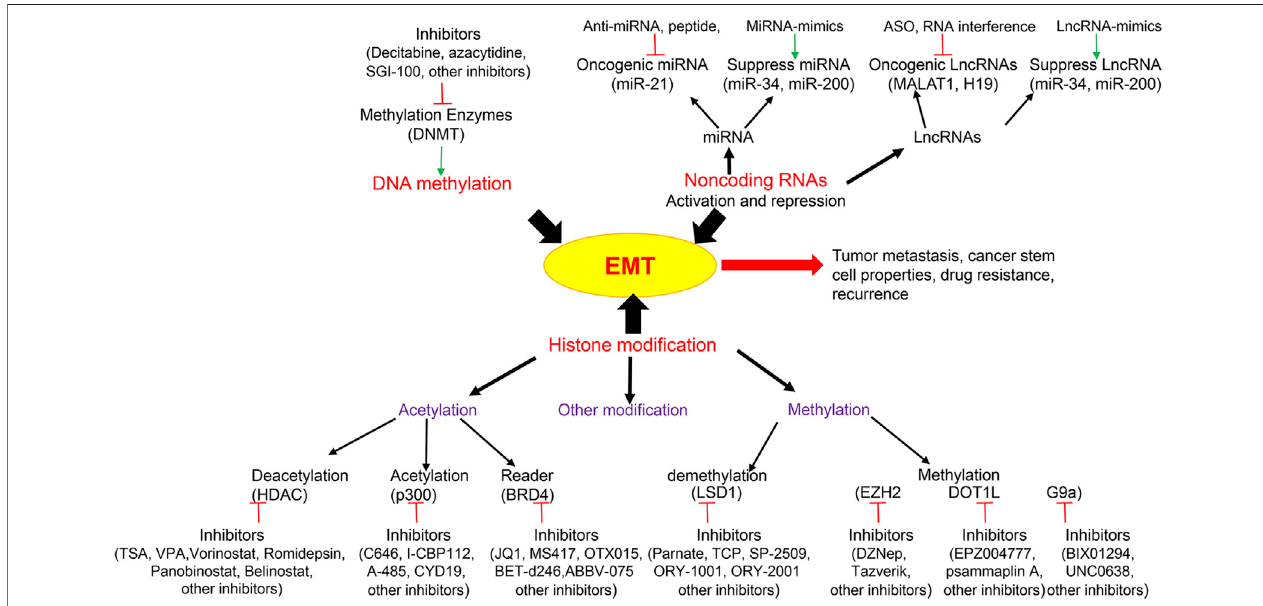
FIGURE 1 | Epigenetic modi fi cations and related key inhibitors involved in Epithelial-Mesenchymal Transition (EMT). Epigenetic regulations including DNA methylation, histone modi fi cation and non-coding RNAs are integral to EMT which contribute to tumor metastasis, cancer stem cell properties, drug resistance and recurrence. Epigenetic drugs are illustrated to inhibit EMT including histone deacetylase (HDAC) inhibitor, histone acetylase inhibitor, acetylation reader inhibitor, histone methyltransferase inhibitor, histone demethyltransferase inhibitor, DNA methyltransferase (DNMT) inhibitor, and non-coding RNA activation and repression. LncRNA, Long non-coding RNAs; MALAT1, Metastasis Associated Lung Adenocarcinoma Transcript 1; ASO, antisense oligonucleotides; BRD4, Bromodomain- containing protein 4; LSD1, Lysine-speci fi c demethylase 1; EZH2, Enhancer of zeste homolog 2; DOT1L, DOT1 Like Histone Lysine Methyltransferase.